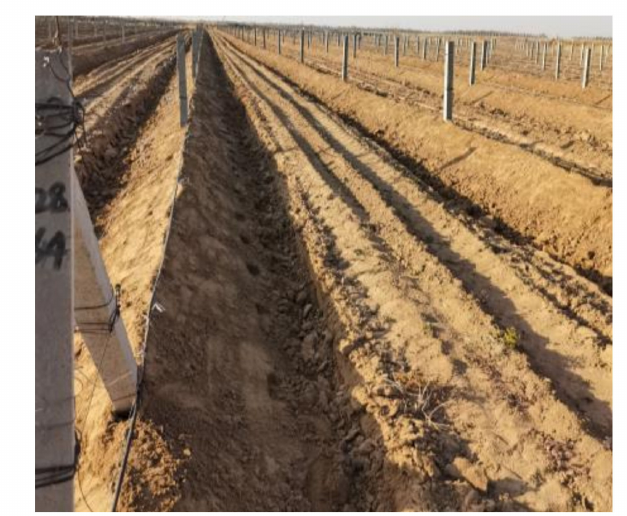
Figure 1. Buried grapevine pictures in November